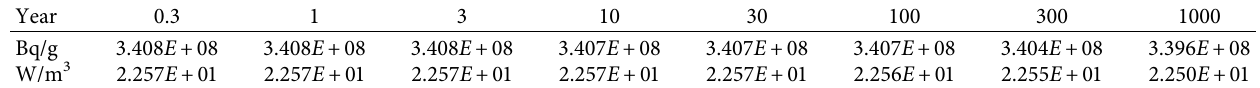
Table 13: Radiological characteristics of Ca